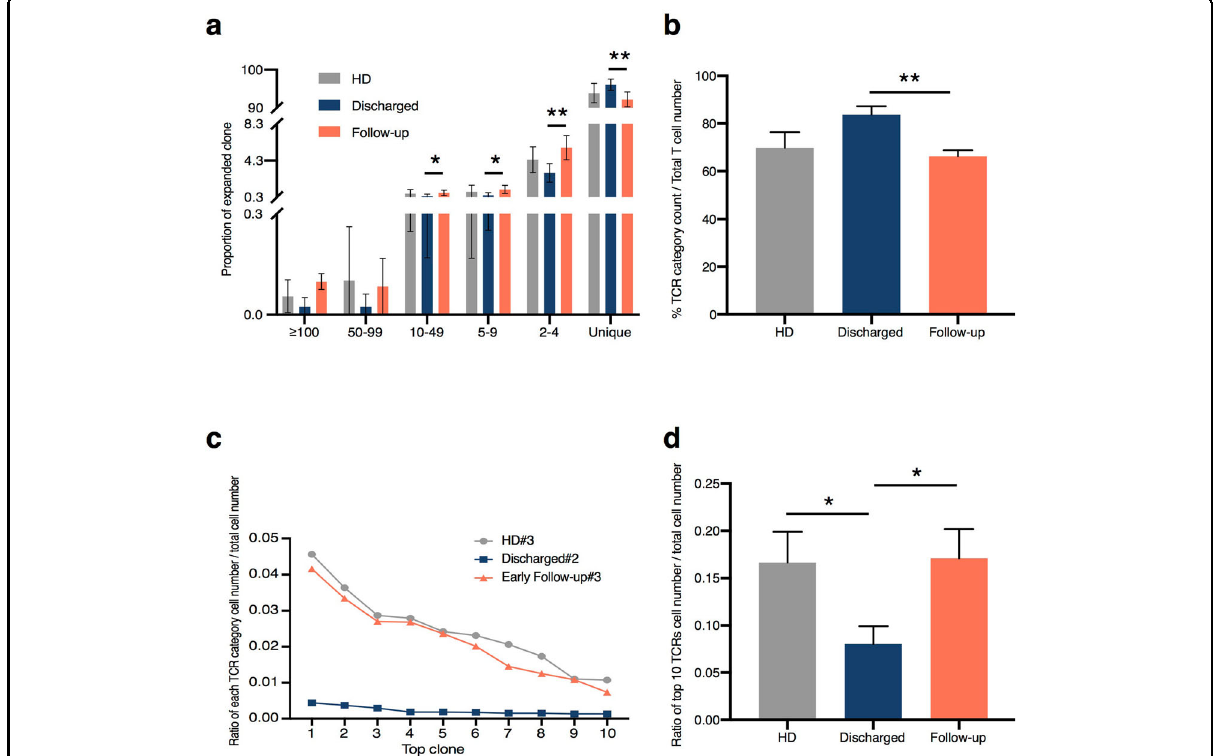
Fig. 3 Clonal diversity and expansion. a The proportions of expanded clone ≥ 100 times expansion, 50 to 99 times expansion, 10 to 49 times expansion, 5 to 9 times expansion, 2 to 4 times expansion and not expanded (unique) in each group ( n = 6 in Discharged and HD groups, n = 7